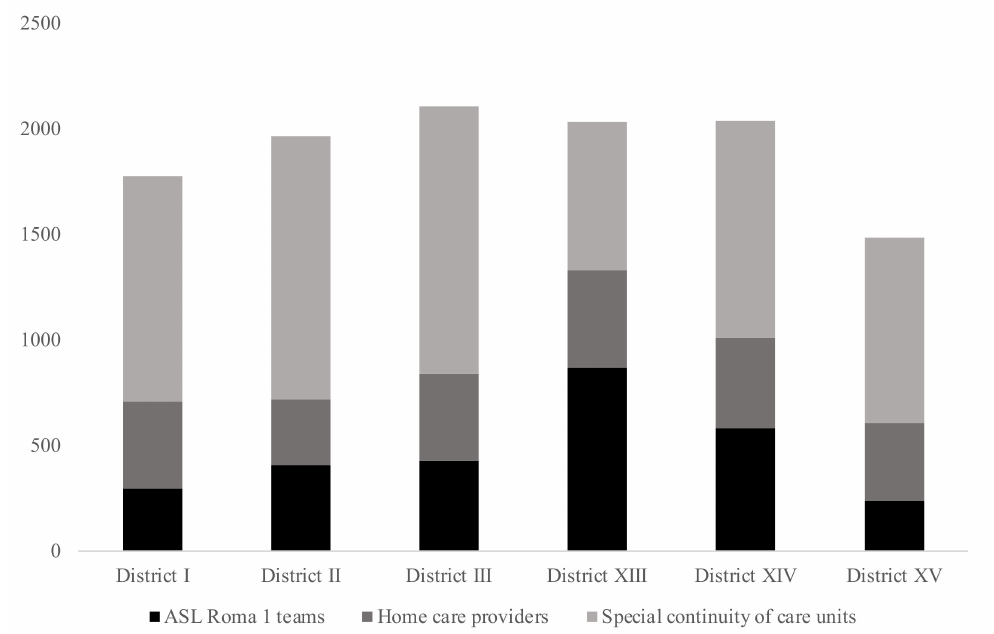
Figure 3. Number of doses (first and second doses) administered per health district and per deliv- ery